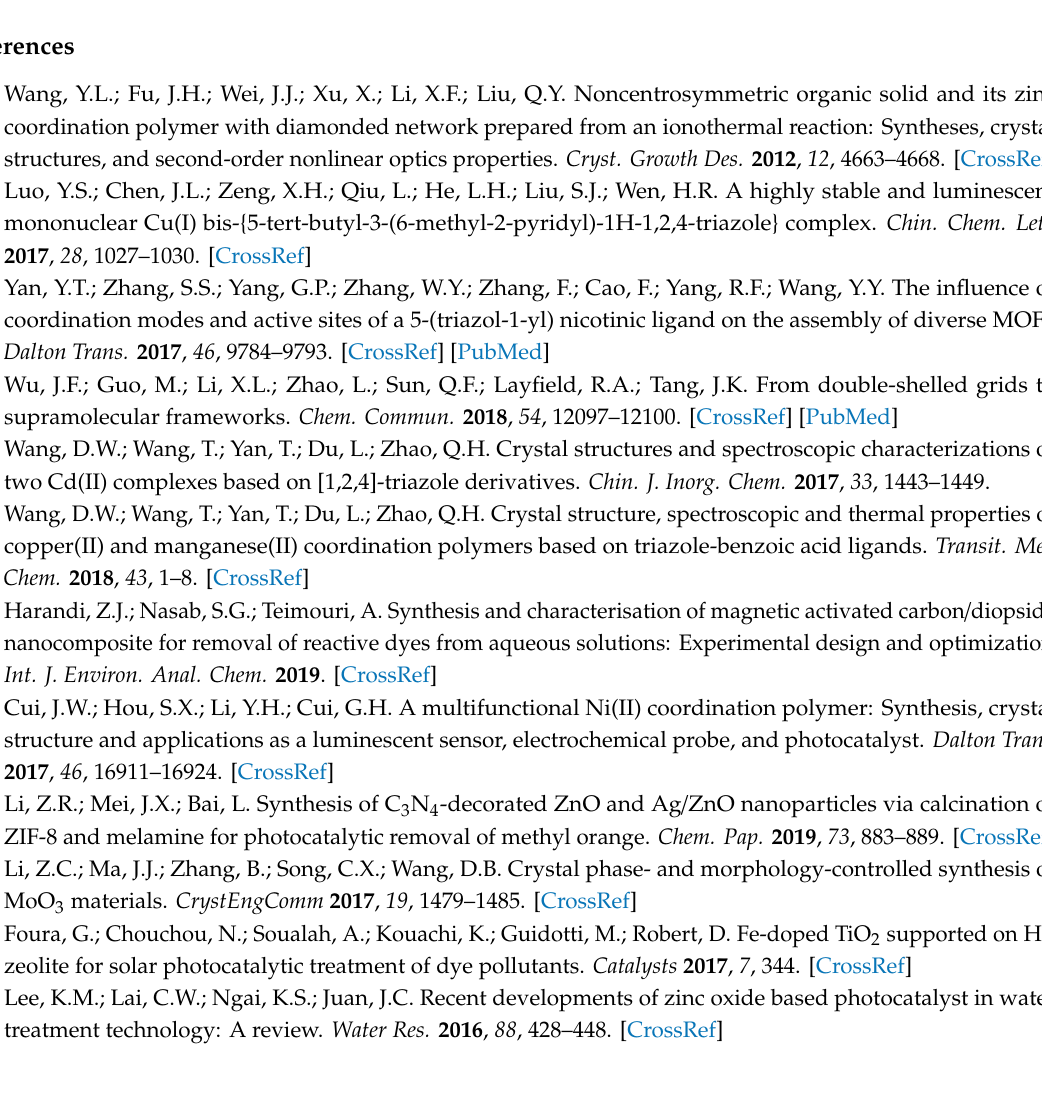
Figure S1: XRD patterns of complex 1 , Figure S2: TGA curve of complex 1 , Figure S3: FT-IR spectrum of complex 1 , Figure S4: UV absorption spectrum of complex 1 in methanol solution at room temperature, Figure S5: Possible photocatalytic mechanisms showing the two excited states of Co(II) catalyst under UV excitation. Author Contributions: D.W. and B.Y. conceived and designed the experiments; T.W. and Y.W. performed X-ray structure determination and analyzed the results; D.W., N.Z. and C.Z. carried out the synthetic and